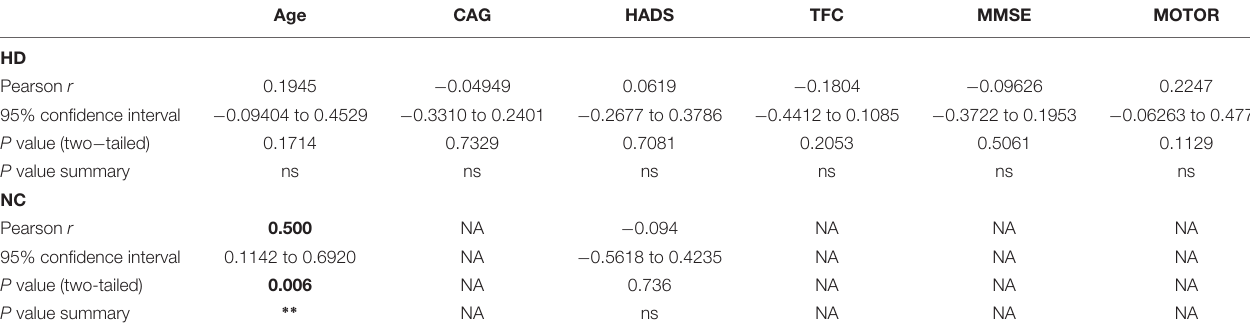
FIGURE 1 | Plasma BDNF levels according to sex and diagnostic group. BDNF levels in plasma (50 ul) were determined by ELISA. (A) BDNF levels did not differ by sex among subjects included in our study as per Student’s t test, unpaired; two-tailed. (B) No significant differences were detected according to diagnostic group between premanifest (PM), manifest HD (HD), and normal controls (NC) as per One-way ANOVA. Data is shown as individual BDNF levels ± SD. TABLE 2 | Correlations between plasma BDNF levels and clinical data in HD patients and control subjects. Age CAG HADS